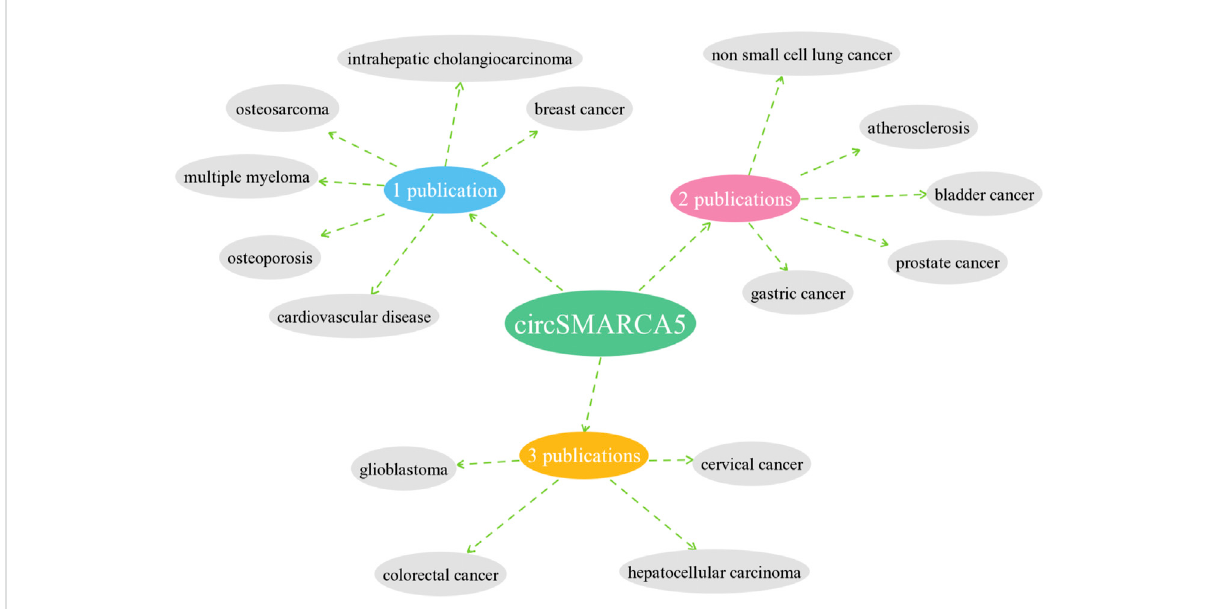
FIGURE 4 Descriptive statistics of the number of studies of circSMARCA5 in each